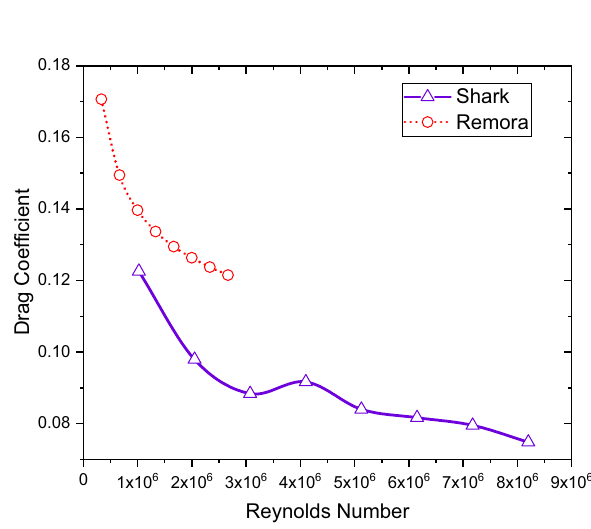
Figure 7. Drag coefficients vs. Reynolds numbers of remora and shark in free